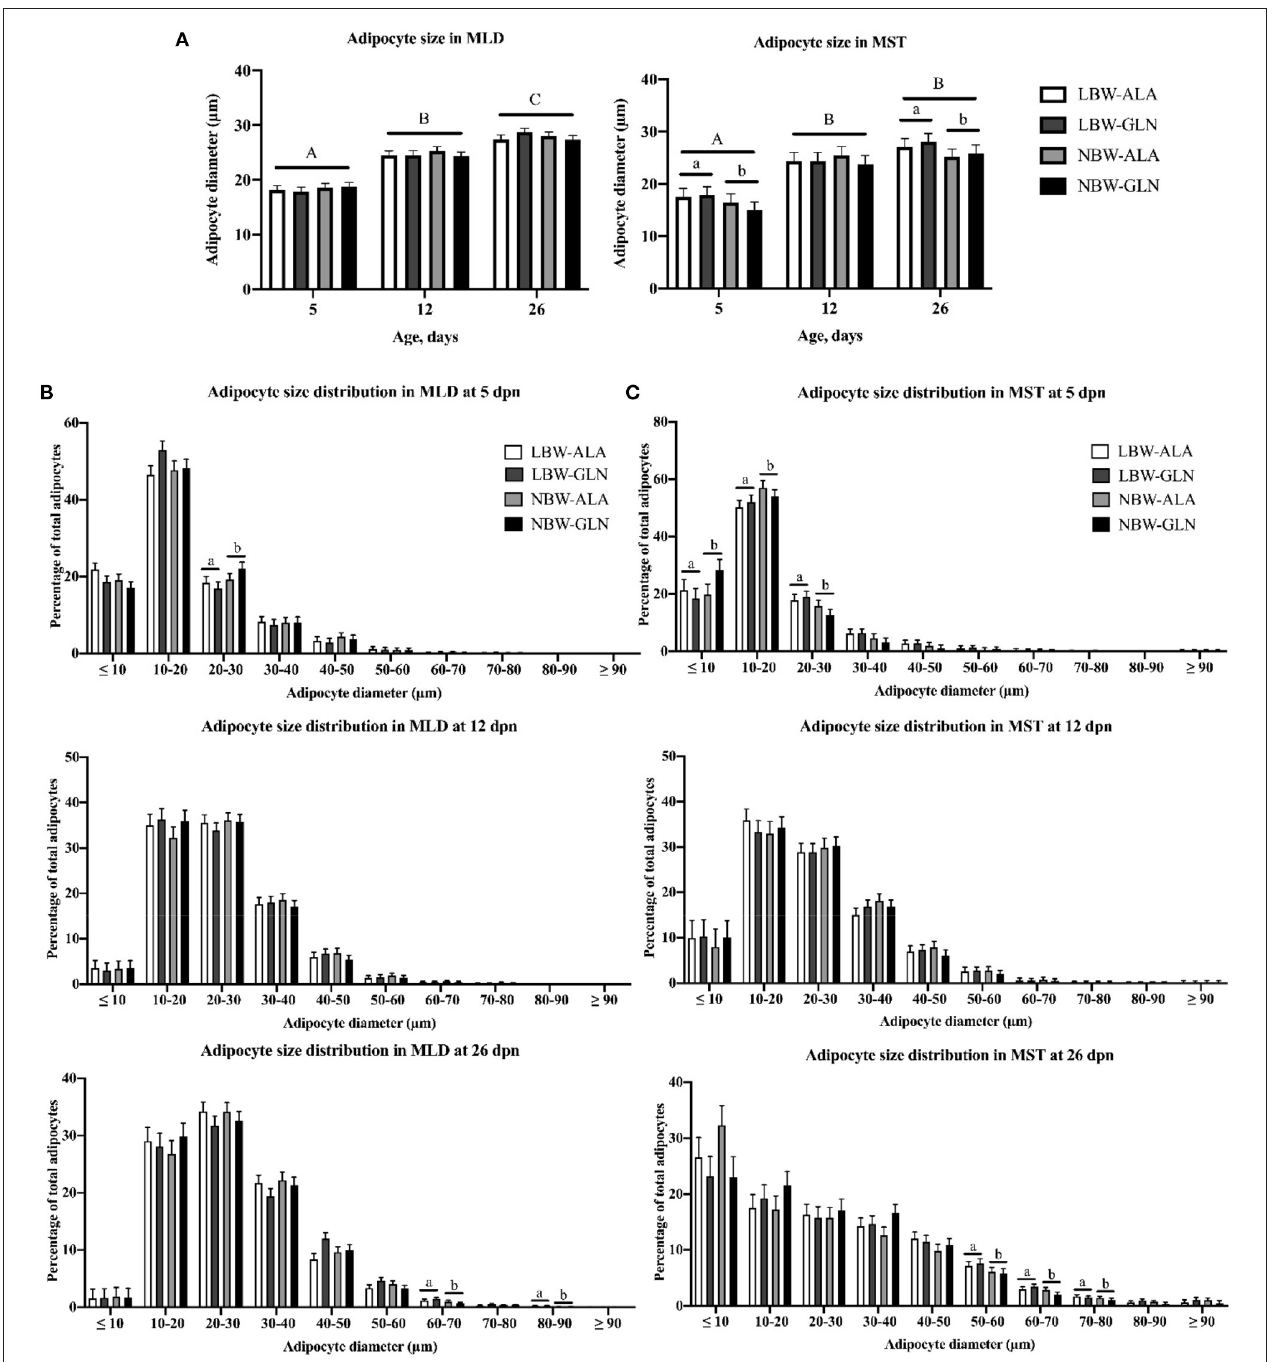
FIGURE 1 | Intramuscular adipocyte diameter and adipocyte size frequency distribution within M. longissimus (MLD) and M. semitendinosus (MST) of low- (LBW) and normal-birth-weight (NBW) piglets at 5, 12, and 26 dpn, supplemented with glutamine (GLN) or alanine (ALA) ( n = 12 per group). (A) Intramuscular adipocyte diameter within MLD and MST; intramuscular adipocyte size distribution within (B) MLD and (C) MST. Values represent LSmeans and SE in error bars. a,b Significant differences between LBW and NBW piglets; A − C Significant differences among ages ( p < 0.05, Tukey–Kramer test).